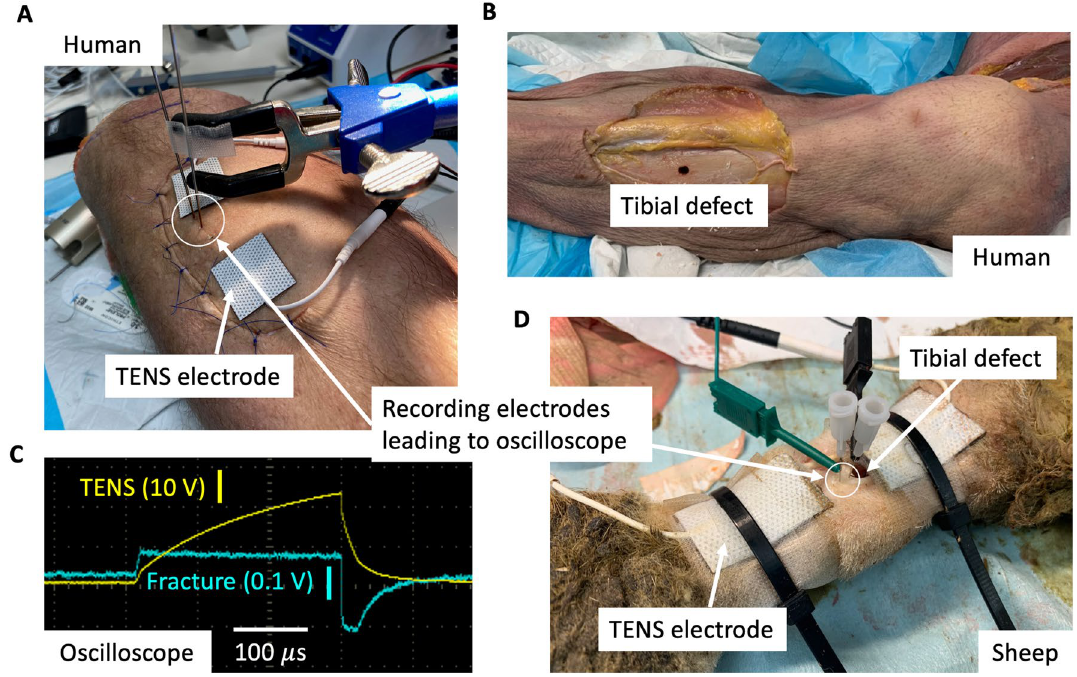
Figure 1. Direct electric field measurements at fracture site during noninvasive EBGS therapy. ( a ) Human cadaver leg instrumented with noninvasive stimulation electrodes akin to an EBGS. Surgical flap was created to access tibial bone to drill defect and two small holes for recording electrodes. Microneurography recording electrodes were inserted percutaneously into bipolar measurement holes in bone after the surgical flap was closed with sutures. ( b ) Tibial bone defect visible with surgical skin flap retracted. ( c ) Oscilloscope screenshot shows voltage delivered through EBGS TENS electrodes externally (yellow trace) and recording at tibial